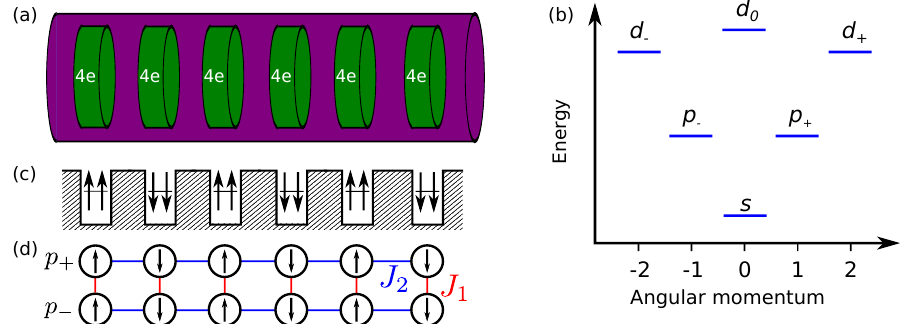
Figure 4. Artificial Haldane chain in a chain of quantum dots embedded in a nanowire. ( a ) the schematic view of the chain. The green disks are the QDs, the violet cylinder is the nanowire, and “4e” denotes filling each dot by four electrons; ( b ) the low-energy single-particle energy spectrum of a single dot as a function of the angular momentum; ( c ) the schematic view of the ground state of the whole chain. The two electrons on p orbitals of each dot polarize ferromagnetically, which is signified by parallel arrows. The tunneling between the dots leads to antiferromagnetic polarization of the effective spins-1, which is denoted by antiparallel arrows in neighboring dots; ( d ) an effective spin ladder, in which every p orbital is treated as localized spin. The coupling is ferromagnetic on the rungs ( J 1 ) and antiferromagnetic on the legs ( J 2